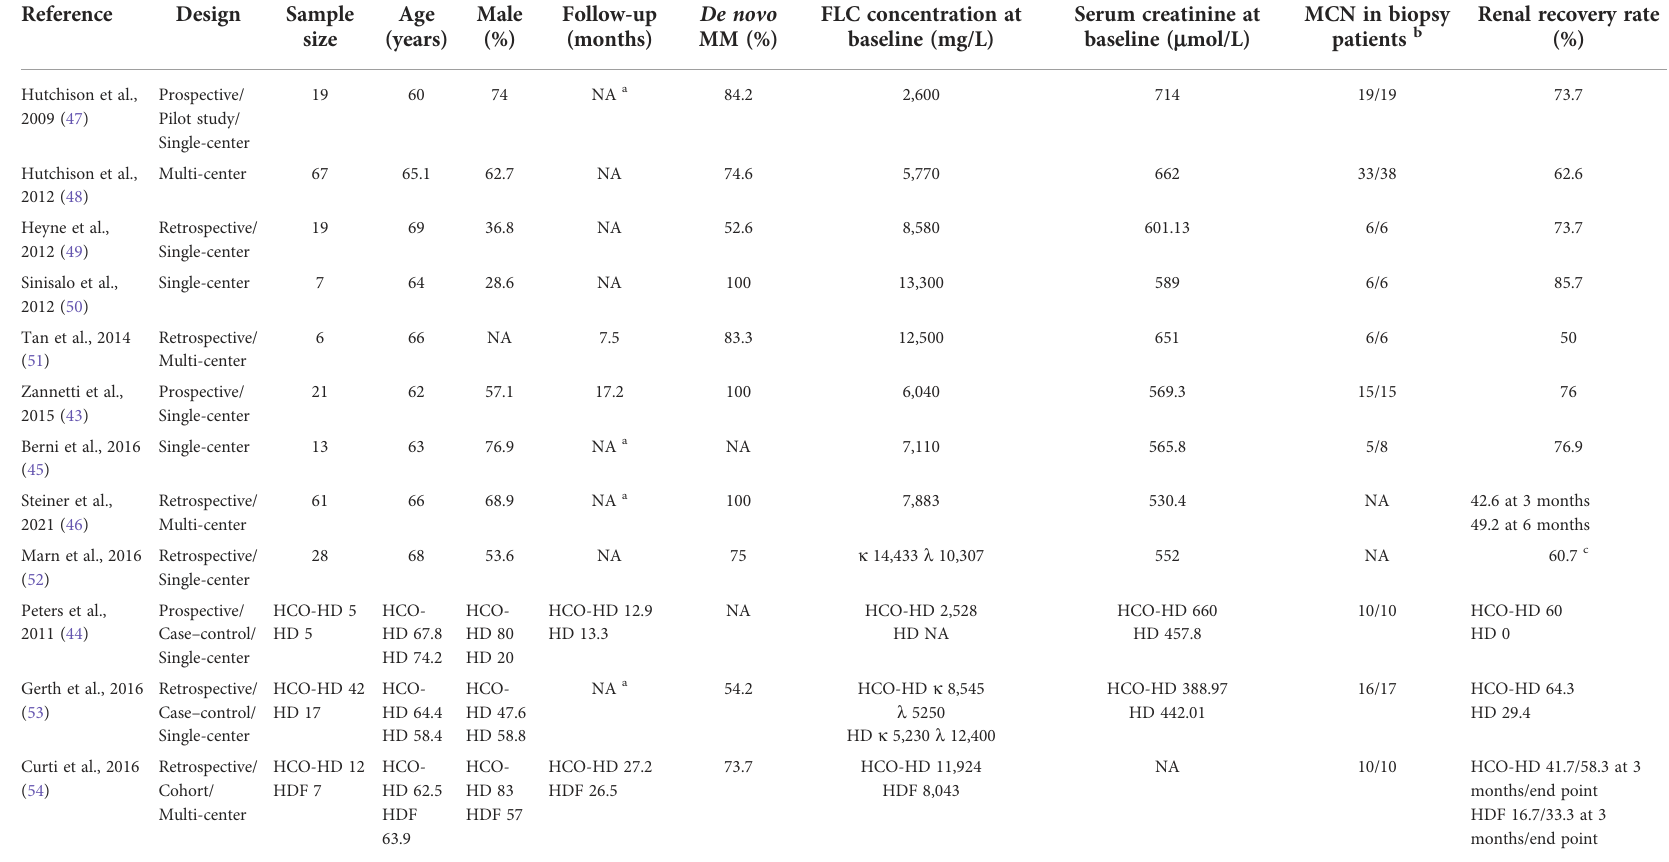
TABLE 1 The renal recovery rate at the end point of previous studies.